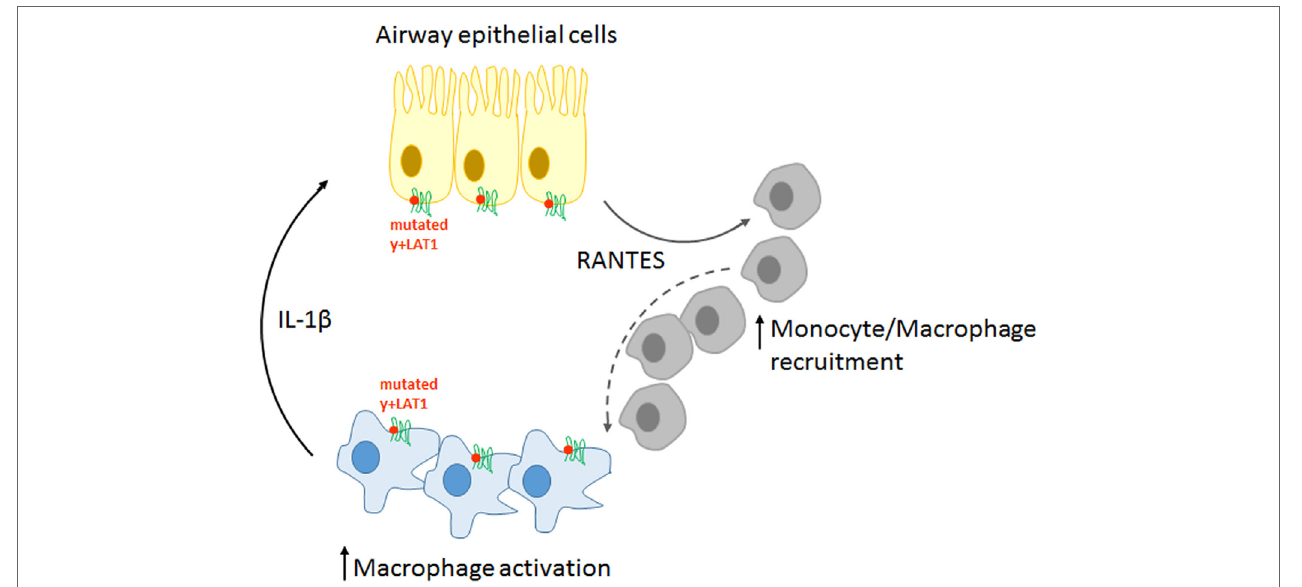
FigUre 8 | Schematic representation of the pathogenic model proposed for pulmonary complications in